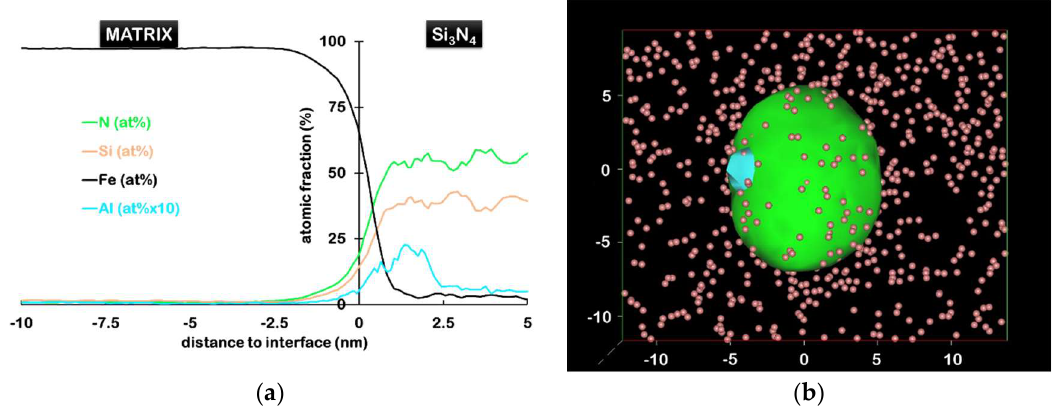
Figure 2. ( a ) Proxigram across Si 3 N 4 /matrix interfaces shown in ( b ). Al–N clusters, selected by 7 at.% isosurface (blue), can be seen at the interface between the Si 3 N 4 precipitate (isosurface N = 25 at.%, shown in green) and matrix ( b ). For clarity, only Si ions in the matrix are shown.